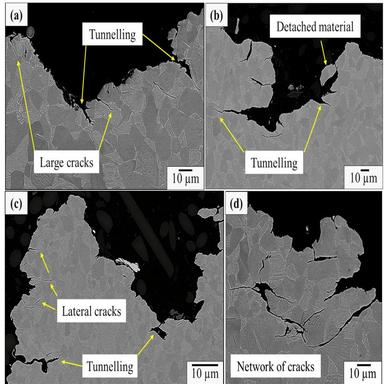
Features of rain erosion damage at advanced stages.